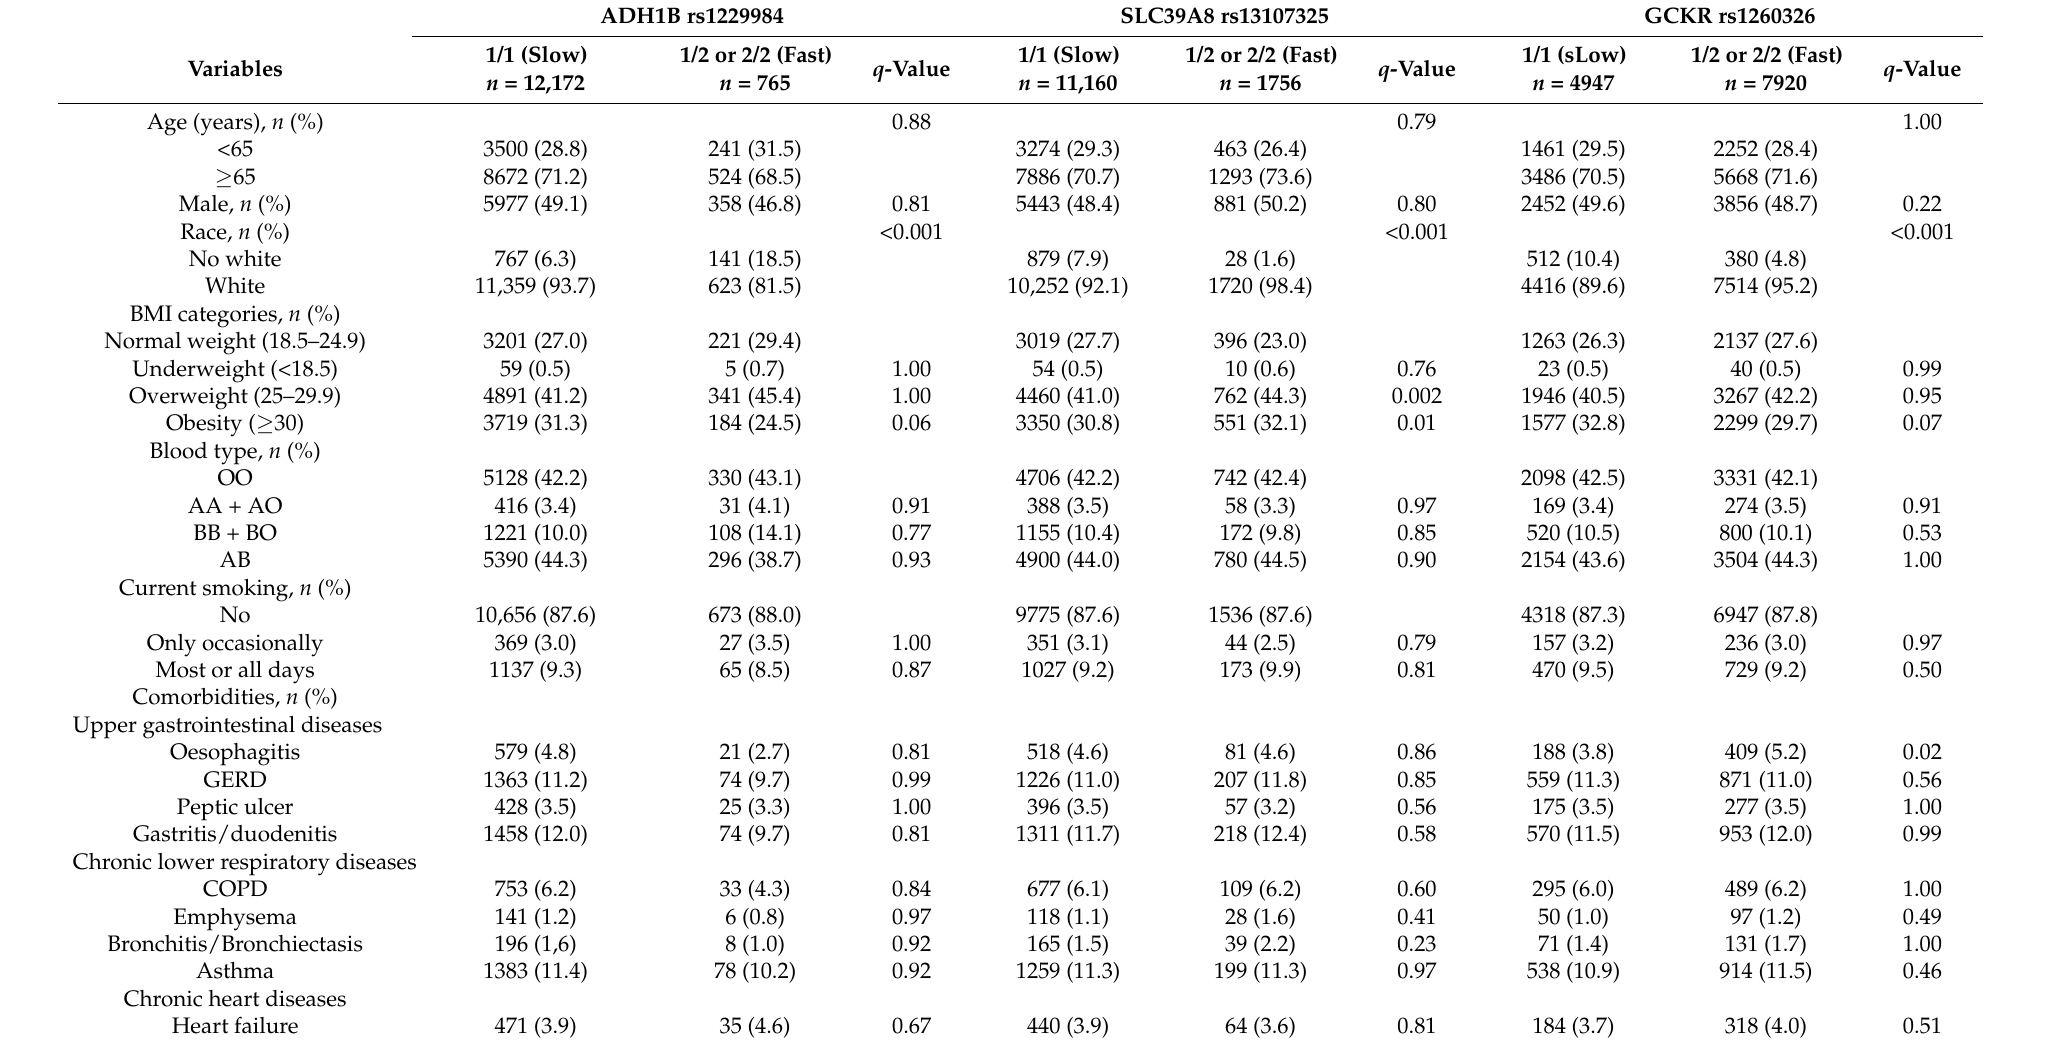
Table 1. Characteristics of participants by rs1229984, rs1260326, and rs13107325